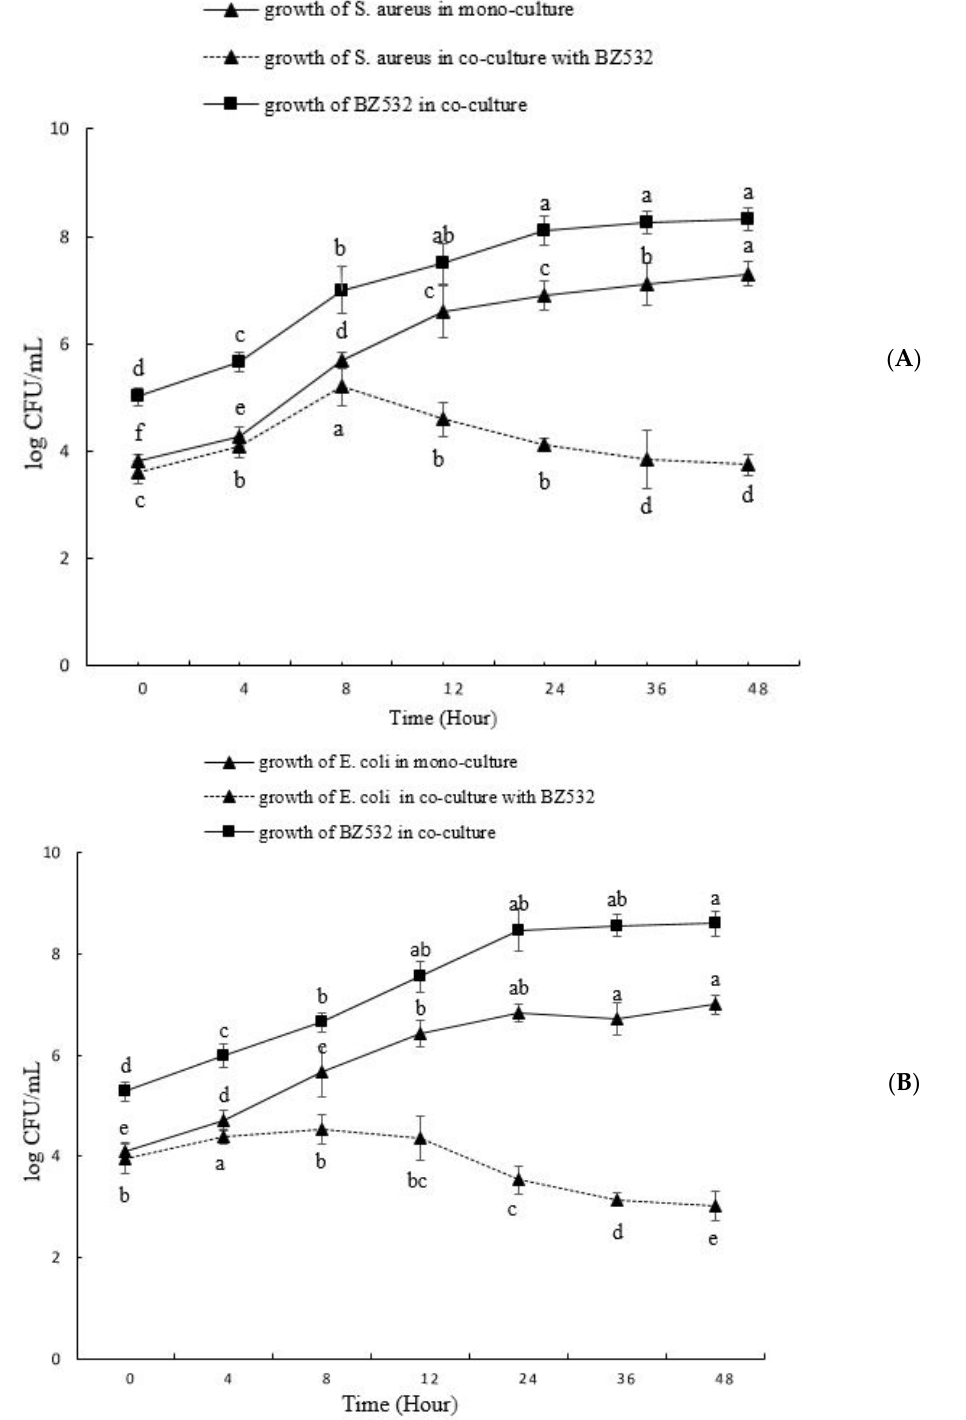
Figure 3. Co-culturing of L. fermentum BZ532 strain against pathogenic strains ( A ) S. aureus and ( B ) E. coli in bozai treatments during 48 h fermentation. Data with different letters represent signifi- cant differences ( p < 0.05).